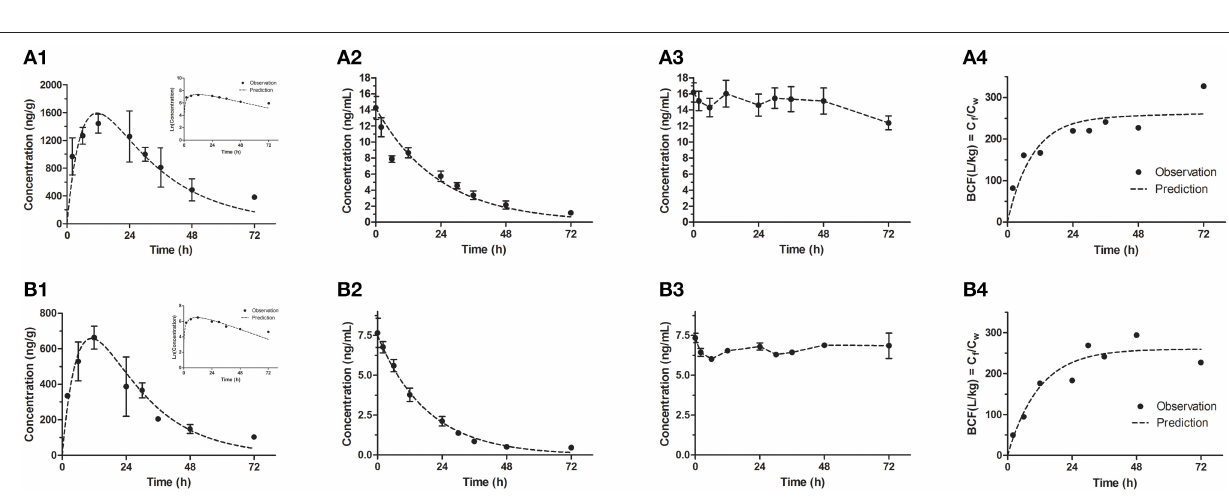
FIGURE 2 | Bioconcentration of emodin in the modified test for high (A1–A4) and low (B1–B4) concentrations. (A1,B1) The concentration-time profiles in eleutheroembryos, with the natural logrithmic concentration-time profiles in the upper right corner; (A2,B2) Concentration-time profiles of exposure medium; (A3,B3) Concentration-time profiles of control groups; (A4,B4) Residues (C f /C w ) in eleutheroembryos exposed to the